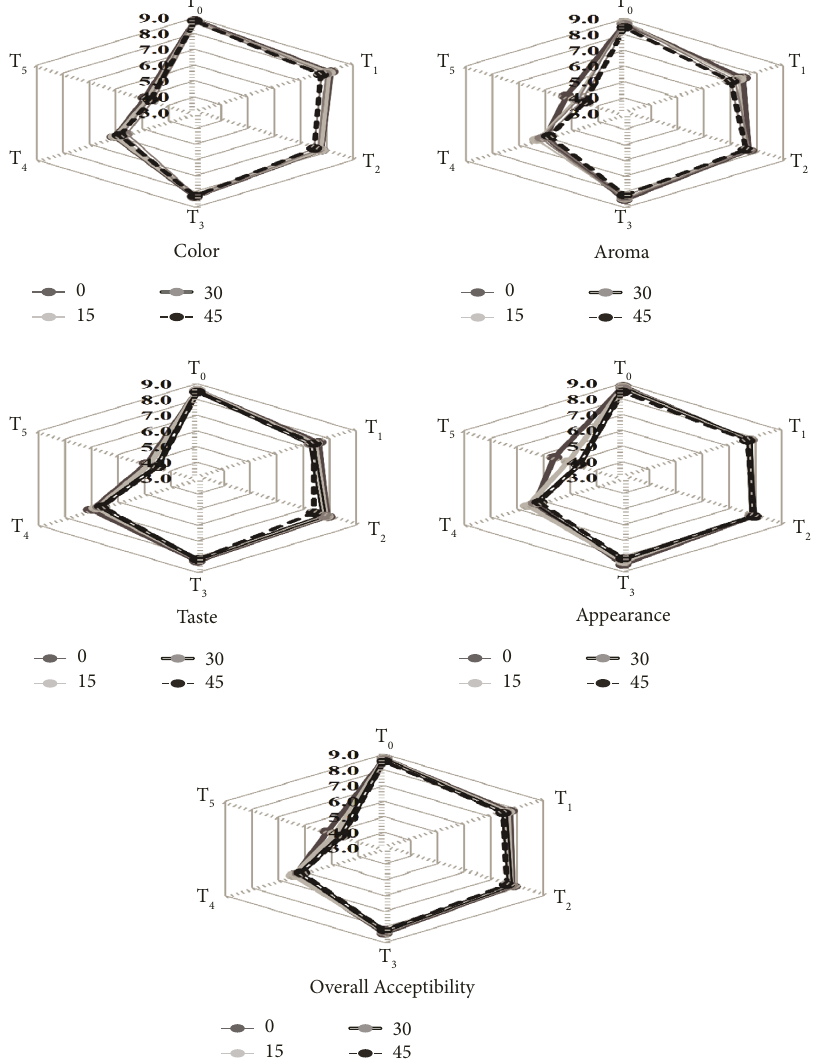
Figure 1: The effect of storage (0, 15, 30, and 45days) on the sensory attributes of fenugreek seed powder–supplemented